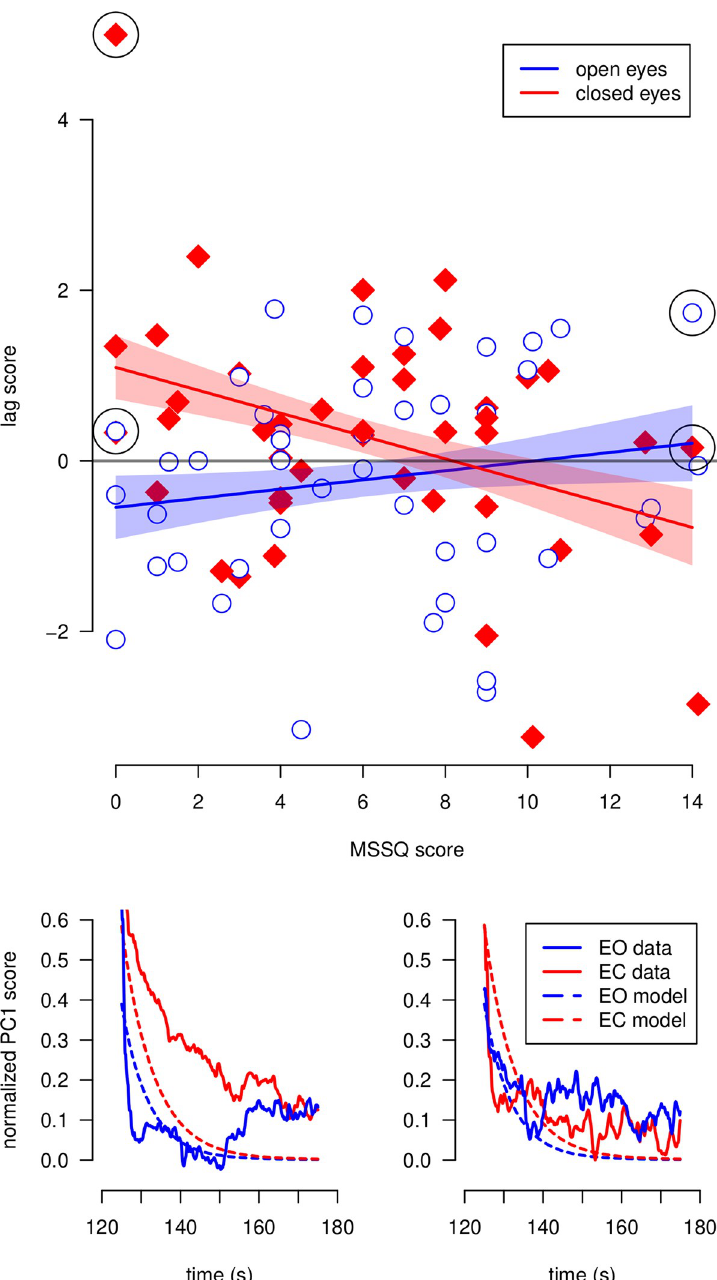
Fig 6. Dependency of the lag score for the return phase on the MSSQ score. On the bottom panel, examples for two selected participants are shown. The participant on the left side has a MSSQ score equal to zero, whereas the MSSQ score of the participant on the right side is equal to 14. The trajectories of the normalized PC1 score for the return phase with EO and EC are indicated with blue and red solid lines, respectively. The trajectories predicted by the exponential model for both vision conditions are represented by dotted lines. On the top panel, the scatter plot of the lag score against the MSSQ score is shown. Each point represents a participant in a given vision condition (open blue circles: open eyes, closed red diamonds: closed eyes). The points surrounded by black circles correspond to the two participants on the bottom panel. Regression lines predicted by the linear model are shown with blue and red lines, for EO and closed, respectively. 95% confidence intervals for the model predictions are shown in colored bands.